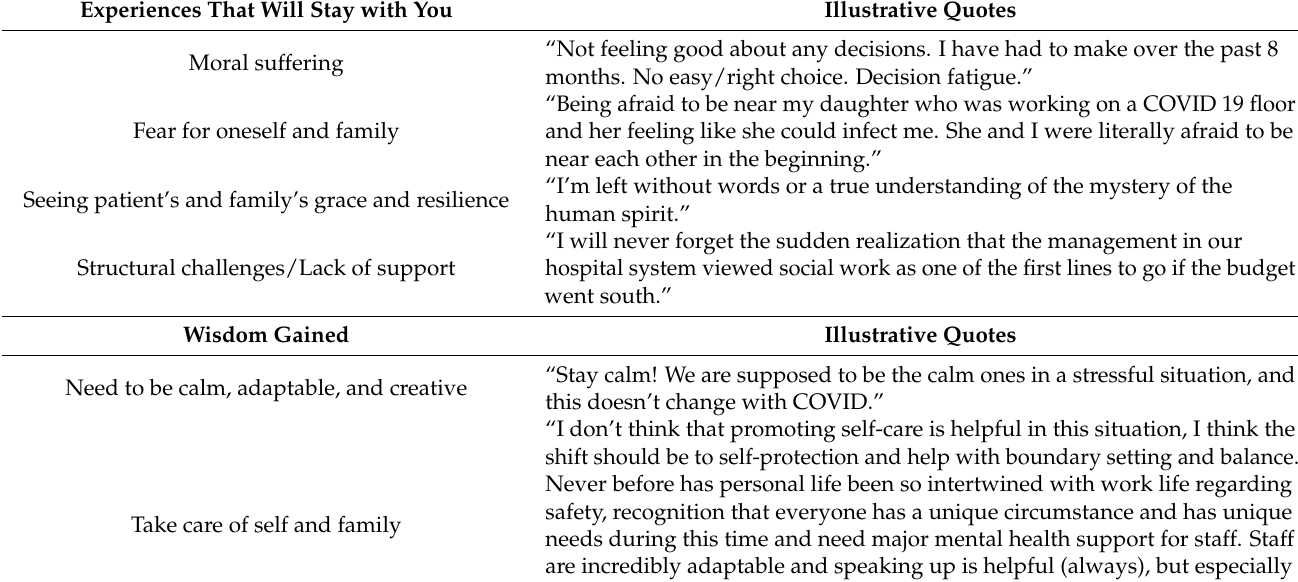
Table 2. Additional Illustrative Quotes from Second Level